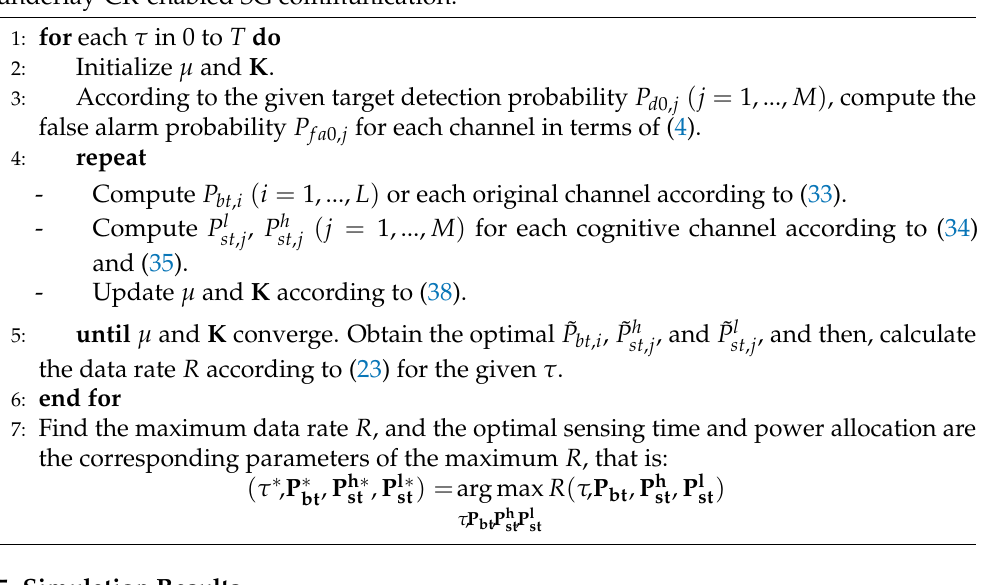
Algorithm 2 Optimal multiband spectrum sensing and power allocation method for underlay-CR-enabled SG